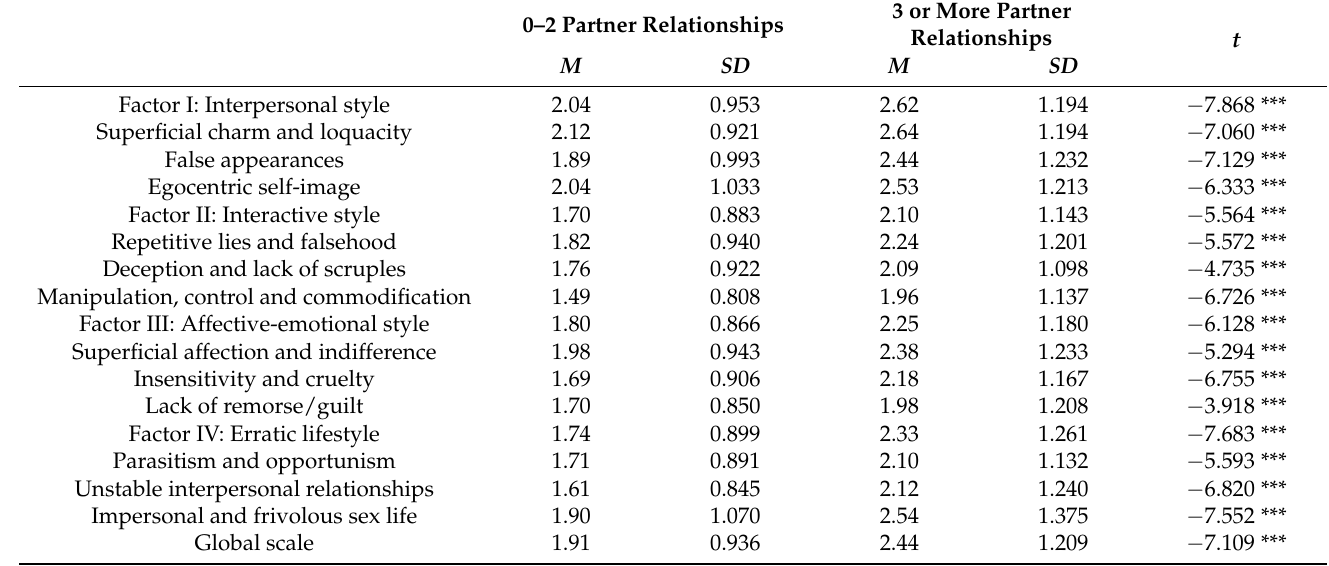
Table 2. Comparison of the averages in subclinical psychopathy with respect to the number of